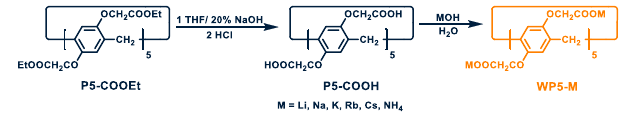
Fig. 2 | General synthetic routes of WP5-M. WP5-M was obtained by reacting the hydroxideof corresponding cations (MOH)with P5-COOH , the hydrolysis product of P5-COOEt .